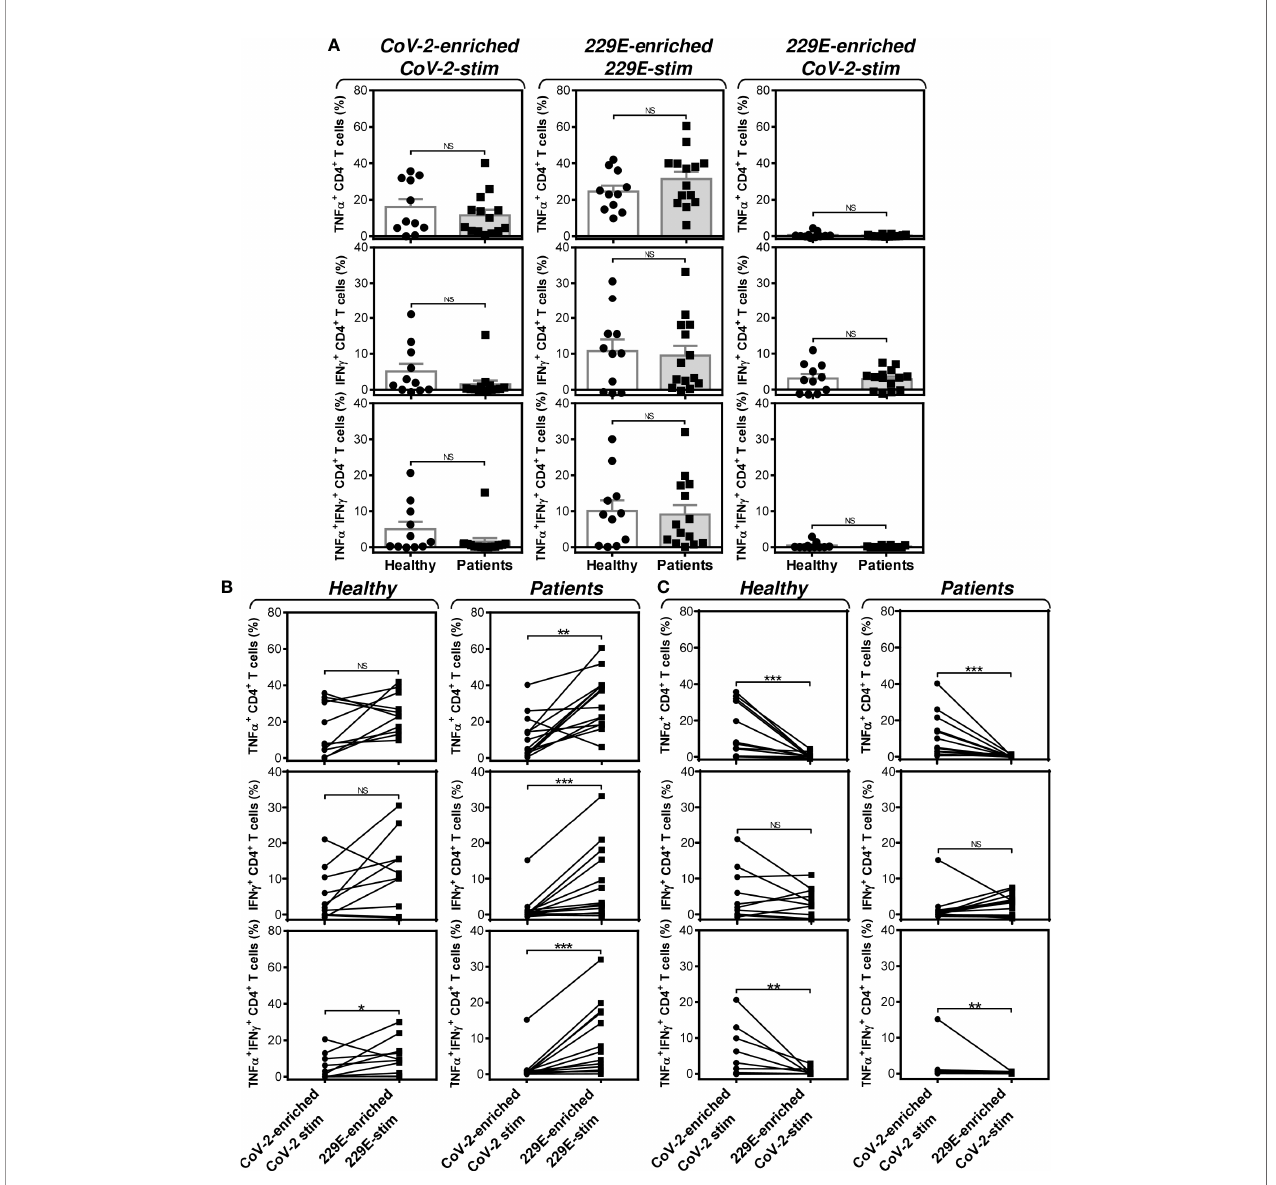
FIGURE 7 | Impact of PCa on the peptide pool-mediated cell culture enrichment with the peptide-speci fi c TNF a -, IFN g -, or TNF a /IFN g -producing CD4 + T cells. (A) Cell cultures of 11 healthy male volunteers (Healthy) and 14 HR metastatic PCa patients (Patients) were enriched with the SARS-CoV-2 (left) or HCoV-229E (229E) (middle and right) peptide pool and stimulated with the corresponding (CoV-2-enriched/CoV-2-stim, 229E-2-enriched/229E-stim) or non-corresponding (229E-2- enriched/CoV-2-stim) peptide pool and proportions of TNF a -, IFN g -, or TNF a /IFN g -producing CD4 + T cells was determined. (B) The differences in responsiveness of CD4 + T cells to SARS-CoV-2 (CoV-2-enriched/CoV-2-stim) and HCoV-229E (229E-enriched/229E-stim) peptide pools in (A) was evaluated between the group of healthy male volunteers (Healthy) and HR metastatic PCa patients (Patients). (C) The differences in responsiveness of CD4 + T cells to SARS-CoV-2-enriched/SARS- CoV-2-stimulated (CoV-2-enriched/CoV-2-stim) and HCoV-229E-enriched/SARS-CoV-2-stimulated (229E-enriched/CoV-2-stim) peptide pools in (A) was evaluated between the group of healthy male volunteers (Healthy) and HR metastatic PCa patients (Patients). In (A) , bars represent mean of values and SEM determined in each group and signi fi cances of differences between the groups are indicated (* P <0.05, ** P <0.01, *** P <0.001, n = 11 healthy male donors (Healthy) and n = 14 HR metastatic PCa patients (Patients), Mann-Whitney U test). In (B, C) , signi fi cances of differences between the groups are indicated (** P <0.01, *** P <0.001, n = 11 healthy male donors (Healthy), n = 14 HR metastatic PCa patients (Patients), Wilcoxon matched-pairs signed-ranks test). In (A – C) , P >0.05 were considered nonsigni fi cant